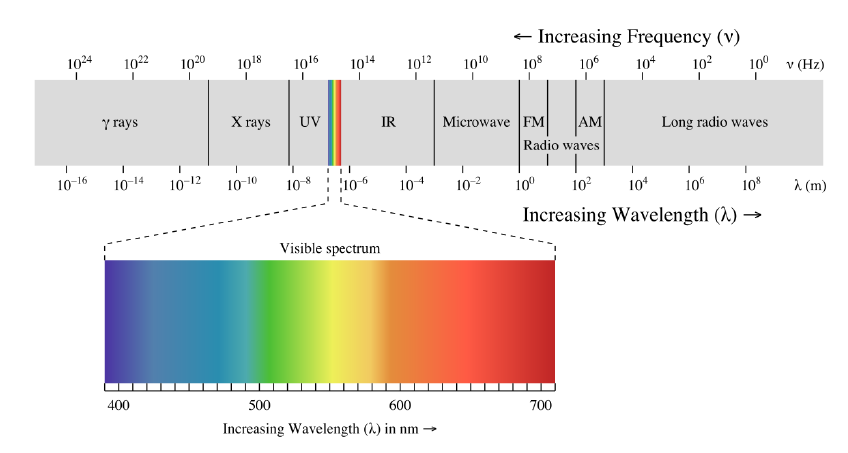
Figure 2. Electromagnetic